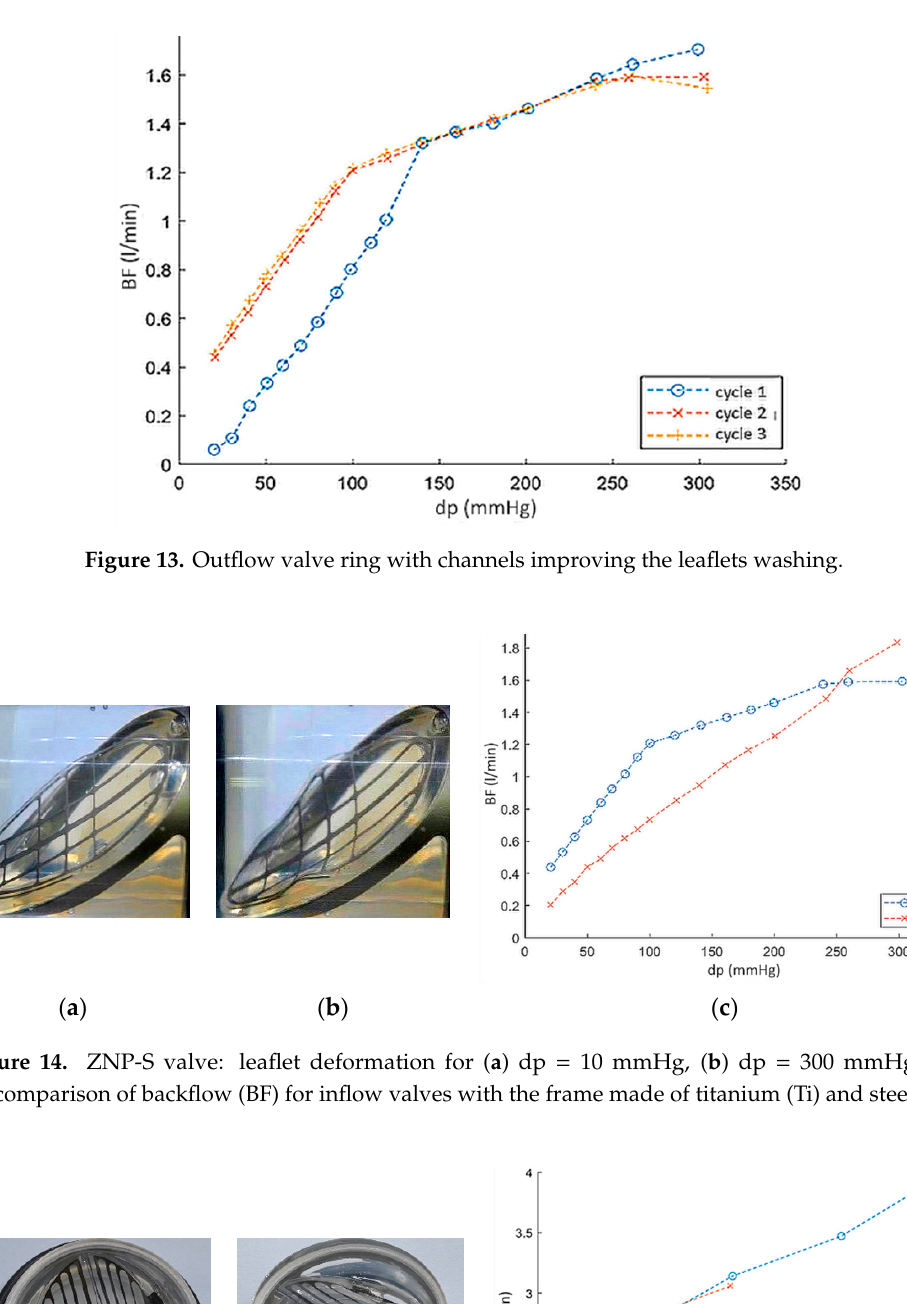
(c) Figure 12. ZNP-Ti valve: leaflet deformation for ( a ) dp = 100 mmHg, ( b ) dp = 760 mmHg and ( c ) influence of leaflet deformation on valve sealing (visible for dp > 400 mmHg). Next experiment compared the backflow vs. pressure characteristics of the valve in 3 cycles of operation: with the leaflet with undistorted geometry (cycle 1), the leaflet deformed by pressure in